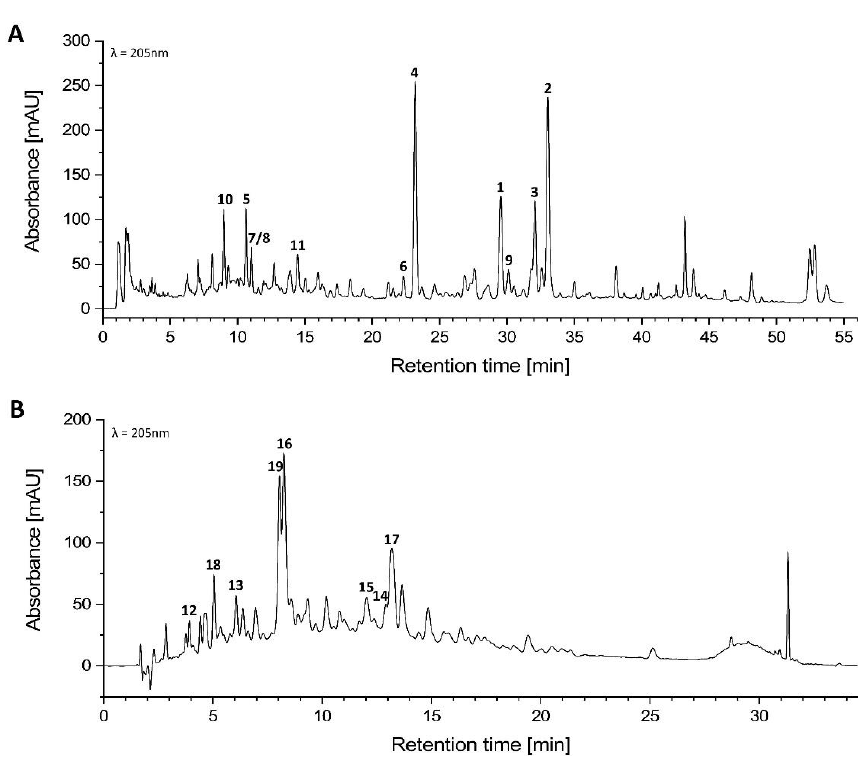
Figure 2. HPLC-UV chromatogram (205 nm) and peak assignment of the ( A ) PE fraction and ( B ) DEE fraction of the methanolic rhizomes and roots extract of Cyperus articulatus ; for HPLC conditions, see Section 4.2 (General experimental methods). Due to a similar extract composition, the HPLC method for the DEE fraction of the methanolic rhizomes and roots extract, after DCM extraction of Scirpoides holoschoenus , was used for the DEE fraction of C. articulatus in ( B ) [47] .